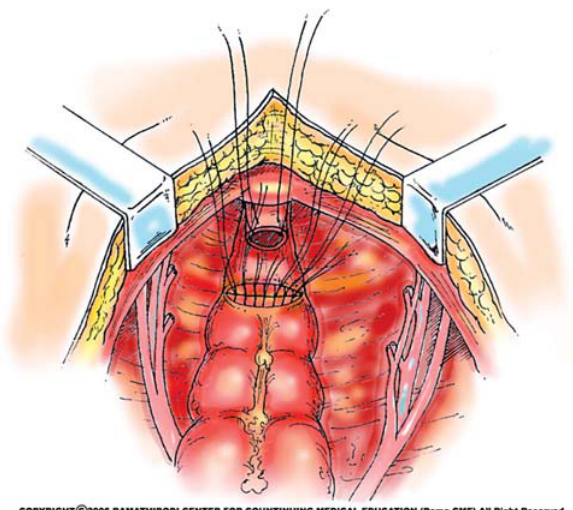
Figure 2 – View of the pelvis from above with urethral suture placement as well as vaginal stump suture, leave sutured end for over sewn with omentum.